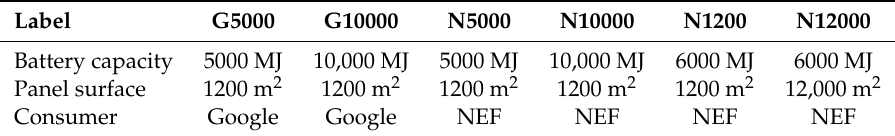
Table 6. Settings used in the first series of